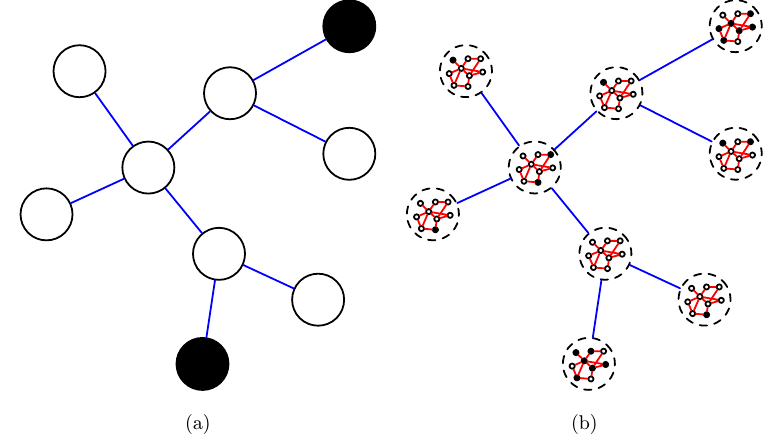
Fig. 1. (a) A complex network of simple spins. Here, a white circle represents a down spin ( S i ¼ (cid:1) 1 , normal agent) while a black circle represents an up spin ( S i ¼ þ 1 , violent agent), and blue links represent interactions between them. (b) A complex network of complex networks. Again, a white circle represents a down spin ( S i ¼ (cid:1) 1 , normal factor) and a black circle represents an up spin ( S i ¼ þ 1 , violent factor), but we distinguish between two types of links: red links between factors within an individual agent, and blue links between individual